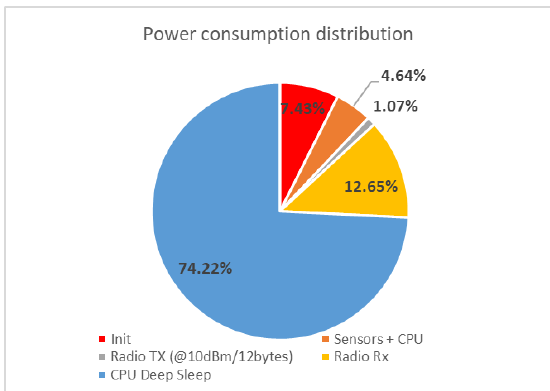
Figure 10. Power consumption distribution for sensor device